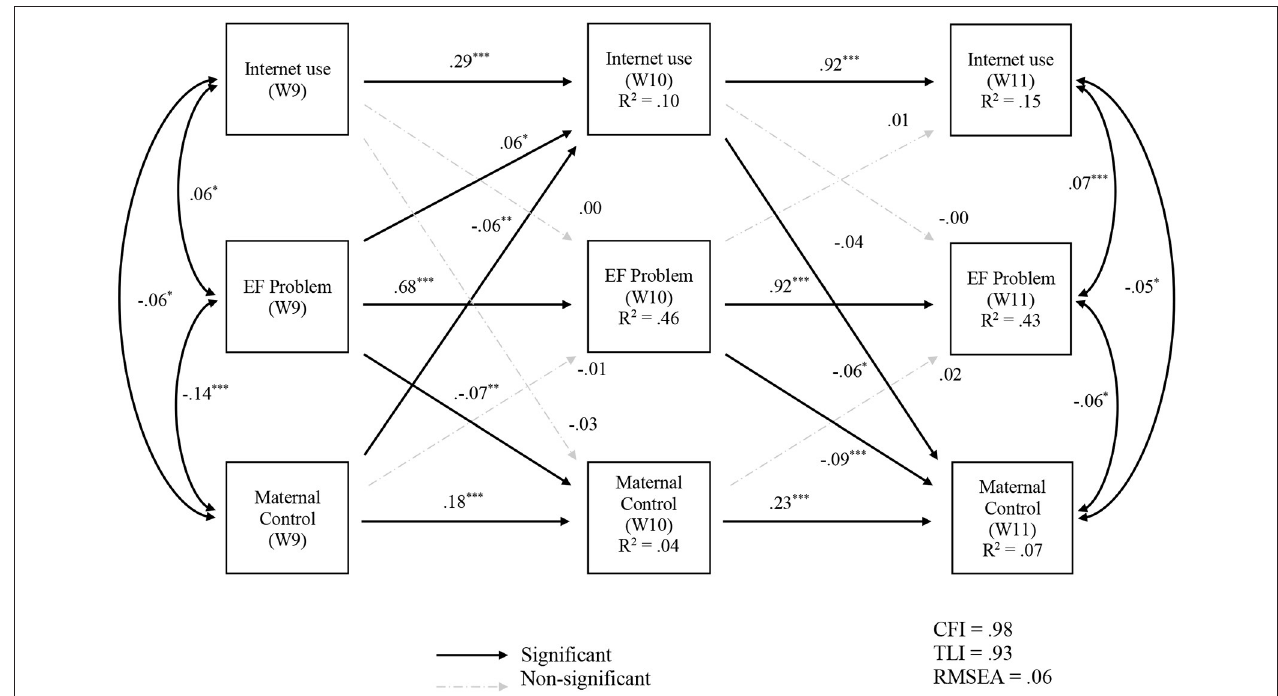
FIGURE 2 | Autoregressive cross-lagged path model of Internet use, executive function problem, and maternal control for total sample ( N = 1,463). Standardized regression coefficients were shown. EF = Executive Function. * p < 0.05, ** p < 0.01, *** p < 0.001.